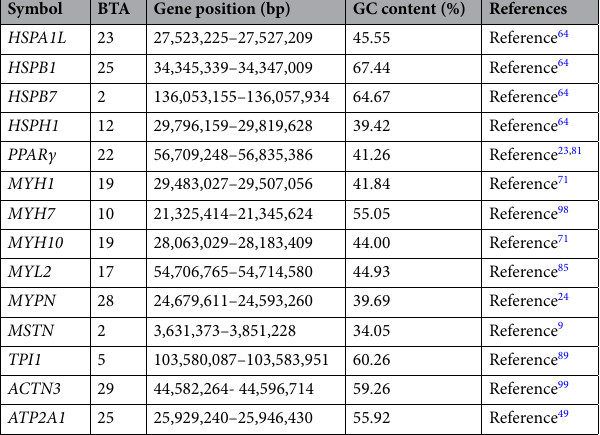
Table 6. Candidate genes related to WHC or drip loss reported in previous reports. BTA Bos taurus autosome. Gene position (bp): position (bp) on ARS-UCD1.2.